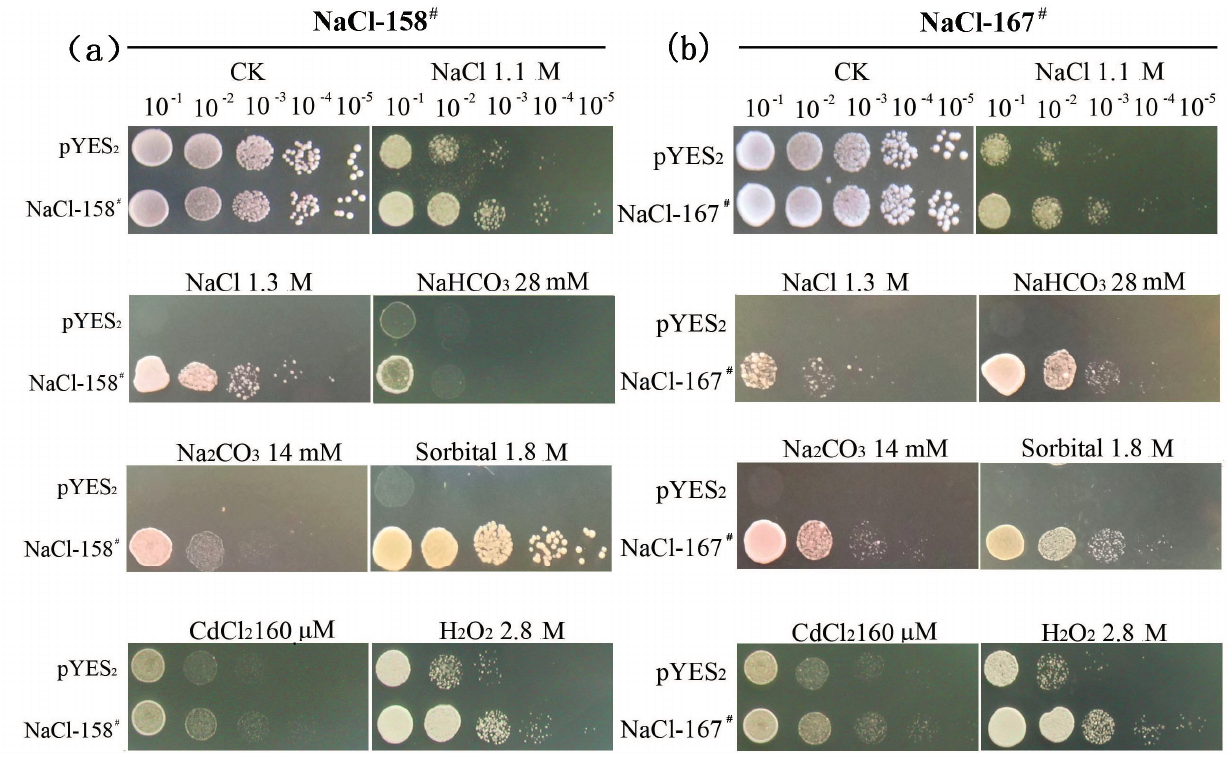
Figure 6. The growth of overexpressing yeast cells in the presence of various abiotic stresses. ( a ) The growth of pYES 2 - NaCl-158 # yeast cells in the presence of various abiotic stresses; ( b ) the growth of pYES 2 - NaCl-167 # yeast cells in the presence of various abiotic stresses. The pictures show the growth of pYES 2 - NaCl-158 # and pYES 2 - NaCl-167 # yeast cells in the presence of CdCl 2 and are the same as the pictures from Figure